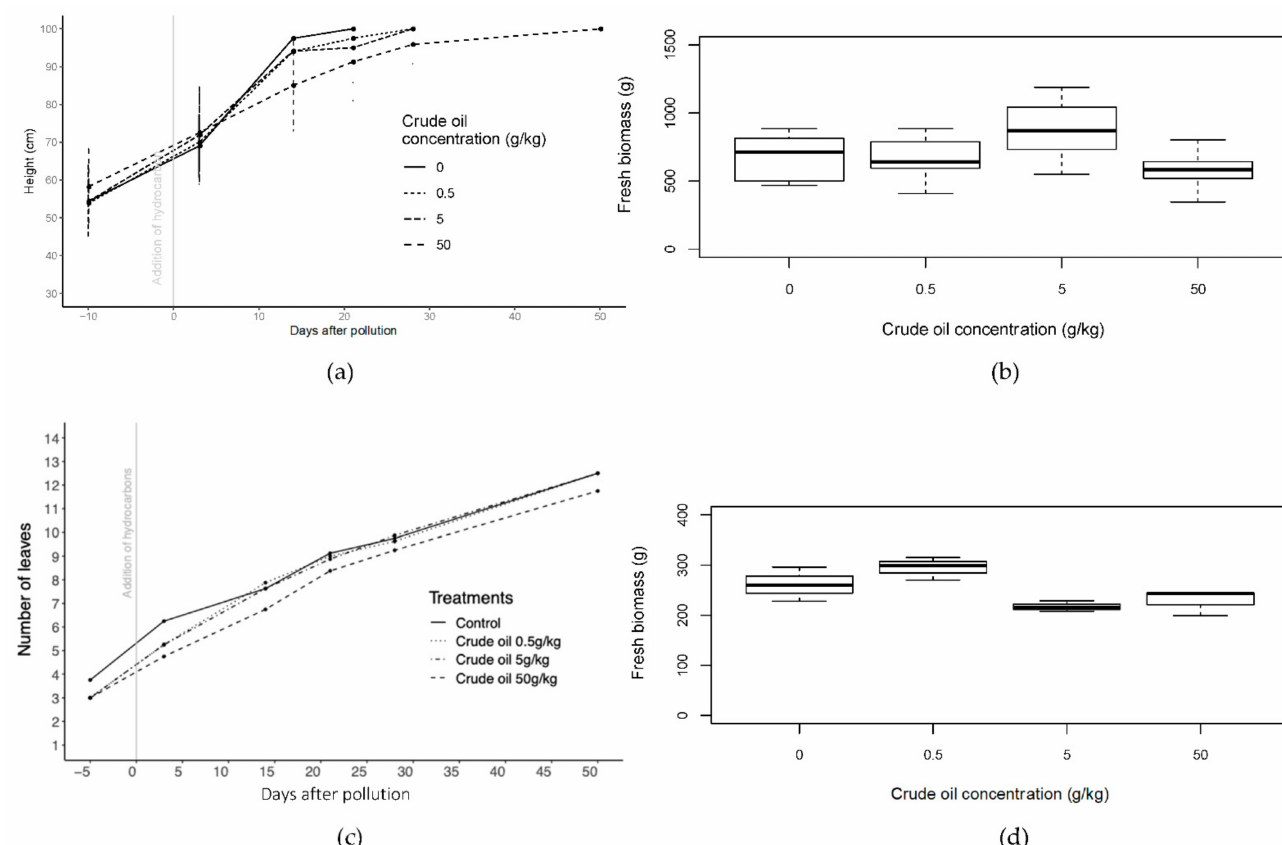
Figure 3. Height of all the crude oil treatments of willow trees before and until 50 days of the addition of the polluted layer. ( b ) Fresh biomass of crude oil treatments of willow trees at the end of the experiment after 50 days of pollution. ( c ) Number of leaves in crude oil treatments of maize plants before and until 50 days of the addition of the polluted layer. ( d ) Fresh biomass of crude oil treatments of maize plants at the end of the experiment after 50 days of pollution. Bars in ( a , c ) represent the standard